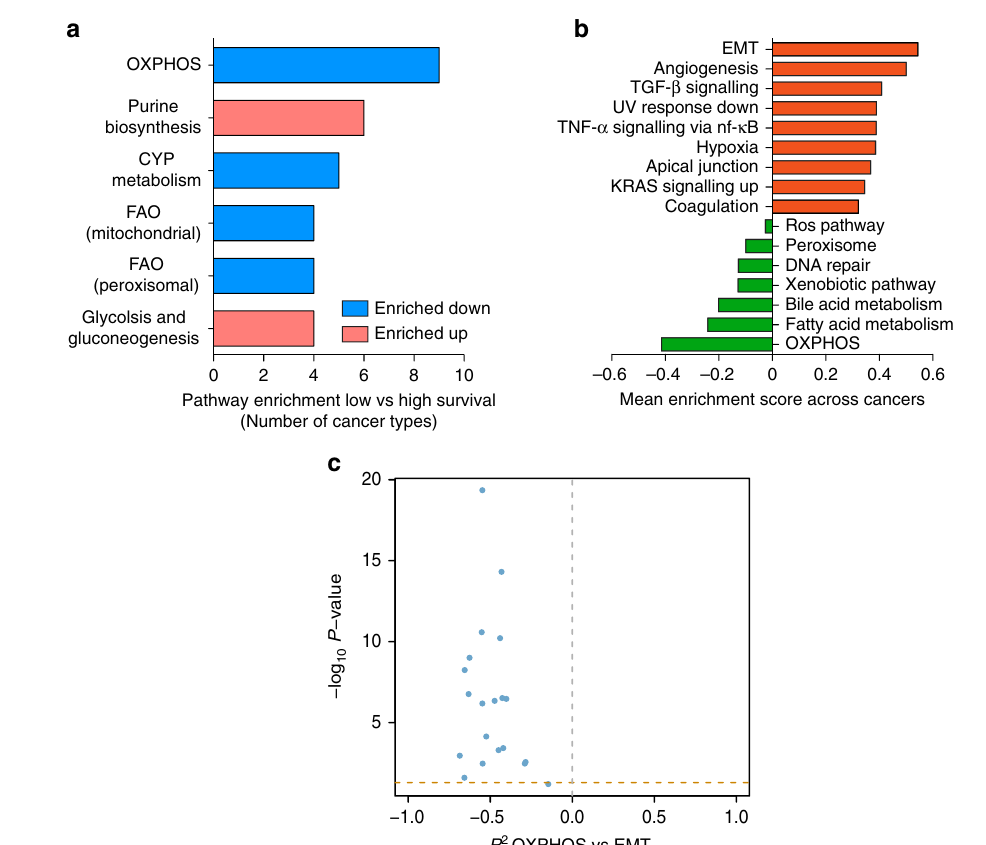
Figure 3 | Downregulation of OXPHOS genes is associated with poor clinical outcome and EMTgene signature. ( a ) Frequency of metabolic pathways found enriched upregulated (red) or downregulated (blue) between low and high survival patients in at least 25% of cancer types. ( b ) Top 10 enriched upregulated and downregulated cancer hallmarks between low and high survival patients across cancer types that showed OXPHOS downregulation (9 cancers). Mean enrichment scores of low vs high survival patients across the nine cancer types considered are shown. ( c ) Volcano plot showing correlation coefficient (Spearman, x axis) and correlation P -values (Spearman, (cid:2) log 10 , y axis) of mean expression of OXPHOS genes compared to mean expression of genes involved in EMT. Horizontal dashed line indicates FDR ¼